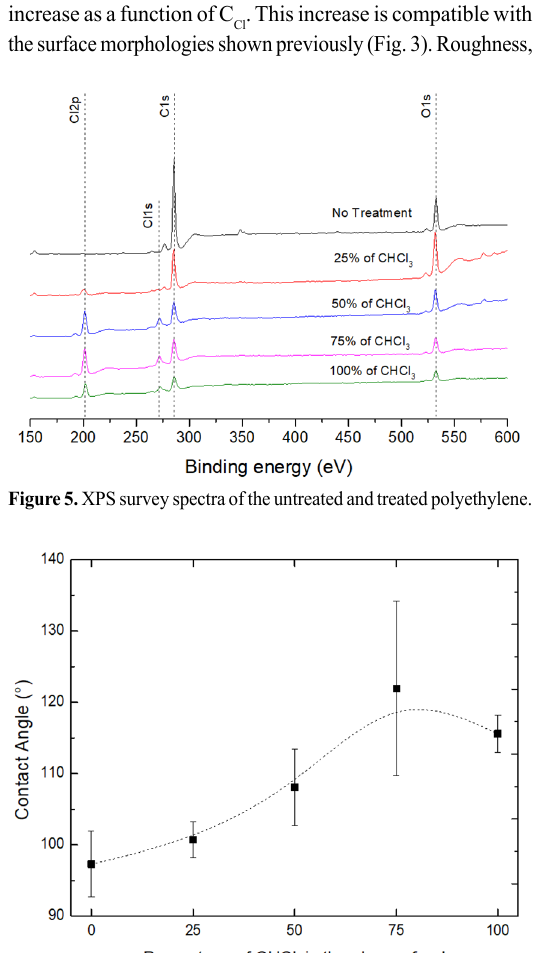
Figure 6. Surface contact angle as a function of C